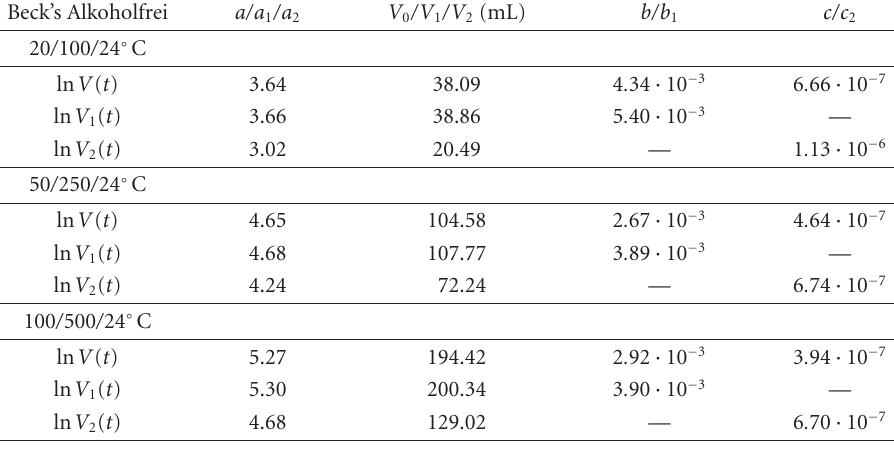
Table 3.2. Influence of the size of the beer glass on the decay of the beer foam ( Beck’s Alkoholfrei ) at 24 ◦ C.